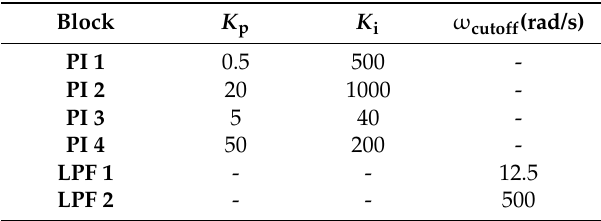
Table 3. Parameters of the RSC’s control